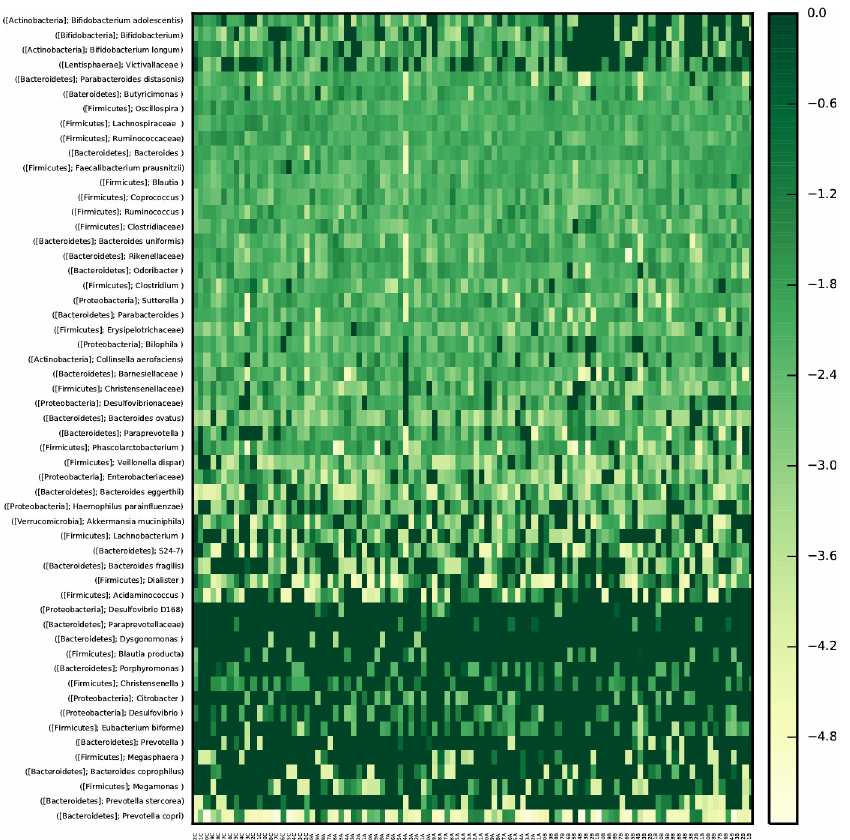
Fig 3. Presence/Absence microbiota heatmap of the study groups. Significant bacterial taxa among groups according to the likelihood-ratio test (G-test) are depicted (P < 0.05, raw and